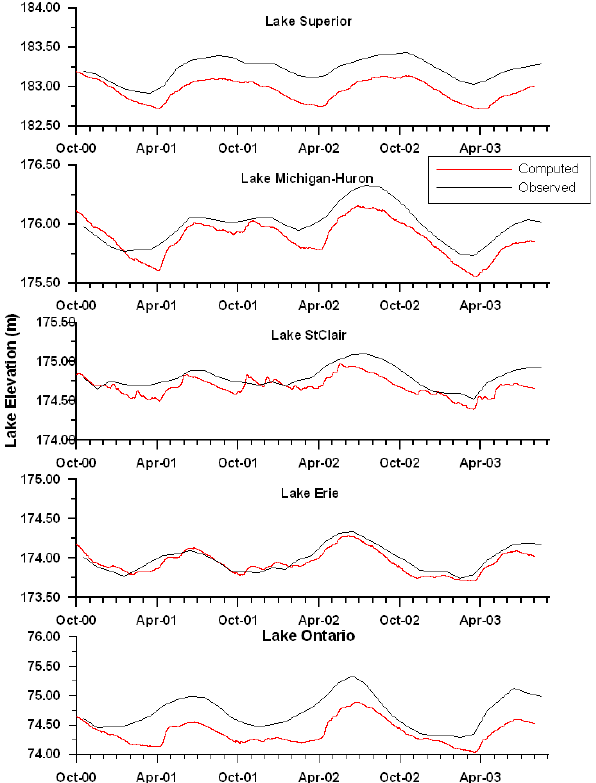
Fig. 9. Lake level estimates for the study time period estimates using WATFLOOD and MESH modelling system.